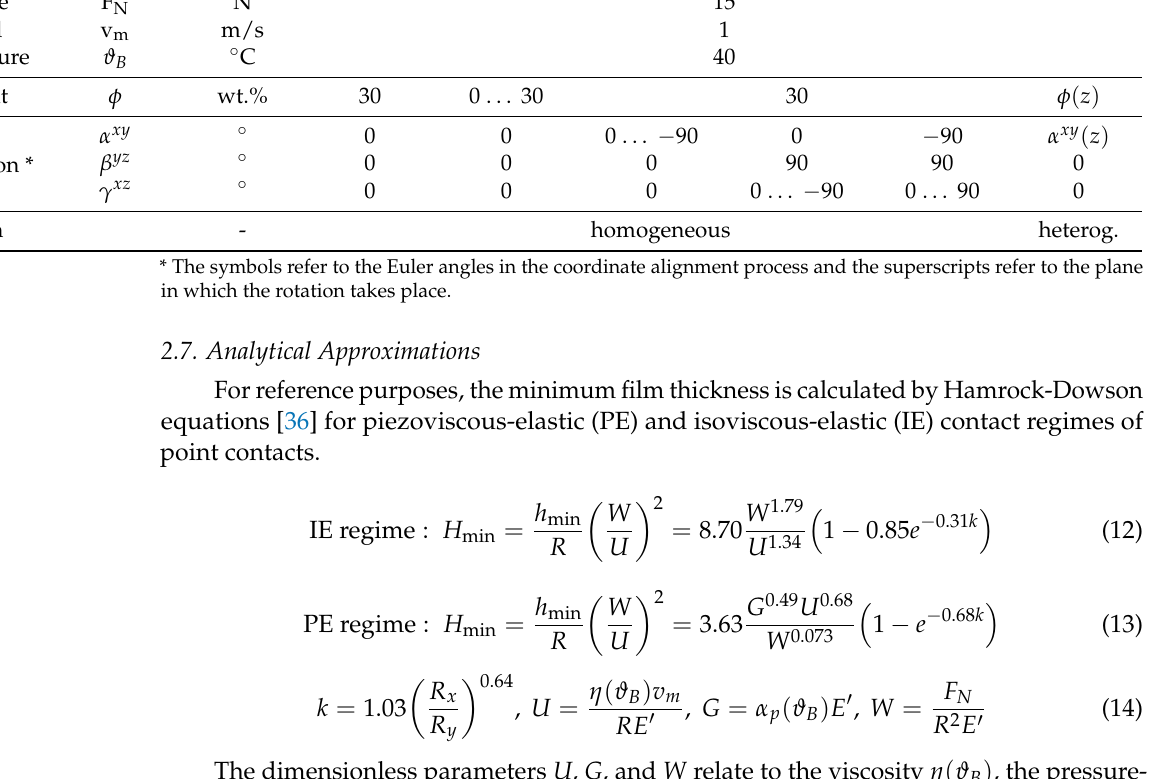
Table 3. Operating condition and parameter variations of the reference and the parametric studies. Unit Ref. Study 1 Study 2.1 Study 2.2 Study 2.3 Study